Question: Write the caption for this figure.
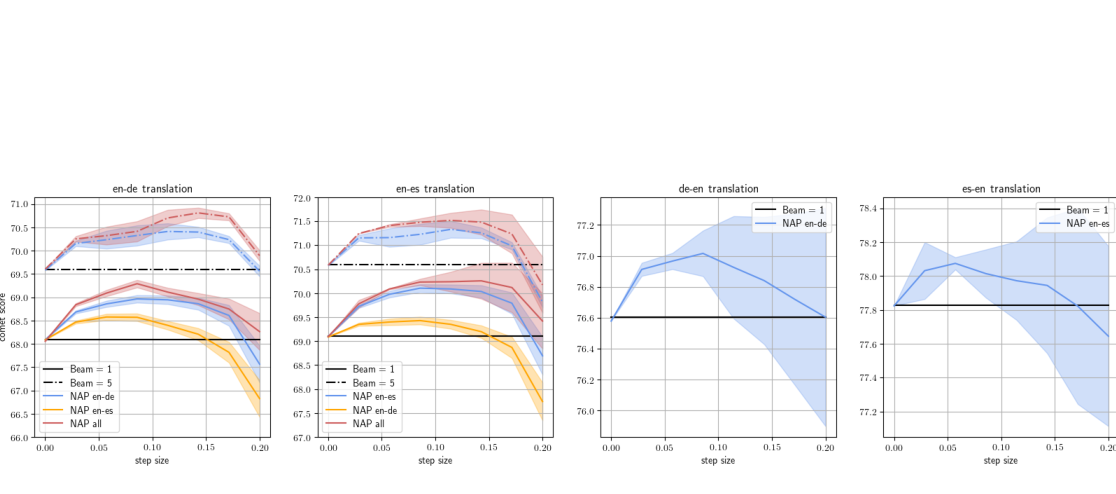
Answer: Modifying encoder outputs using the gradient of a NAP. This shows how the performance changes when we vary the step size α of the modification. The error represents 1 standard deviation. The various figures show the translation task in the title and NAPs (data each was trained on) in the legend.